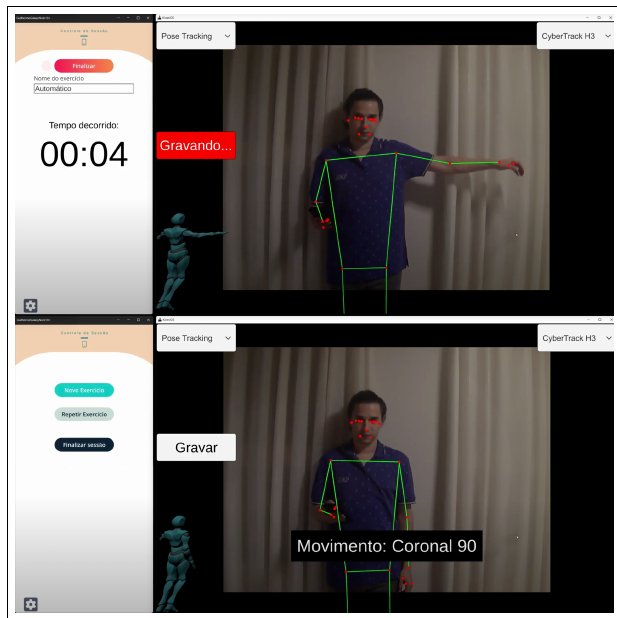
Figure 10. Screenshots of a second phone for remote control (in the left) and the main system classifying a movement (in the right). the result on the main screen. That means the application re- quires internet